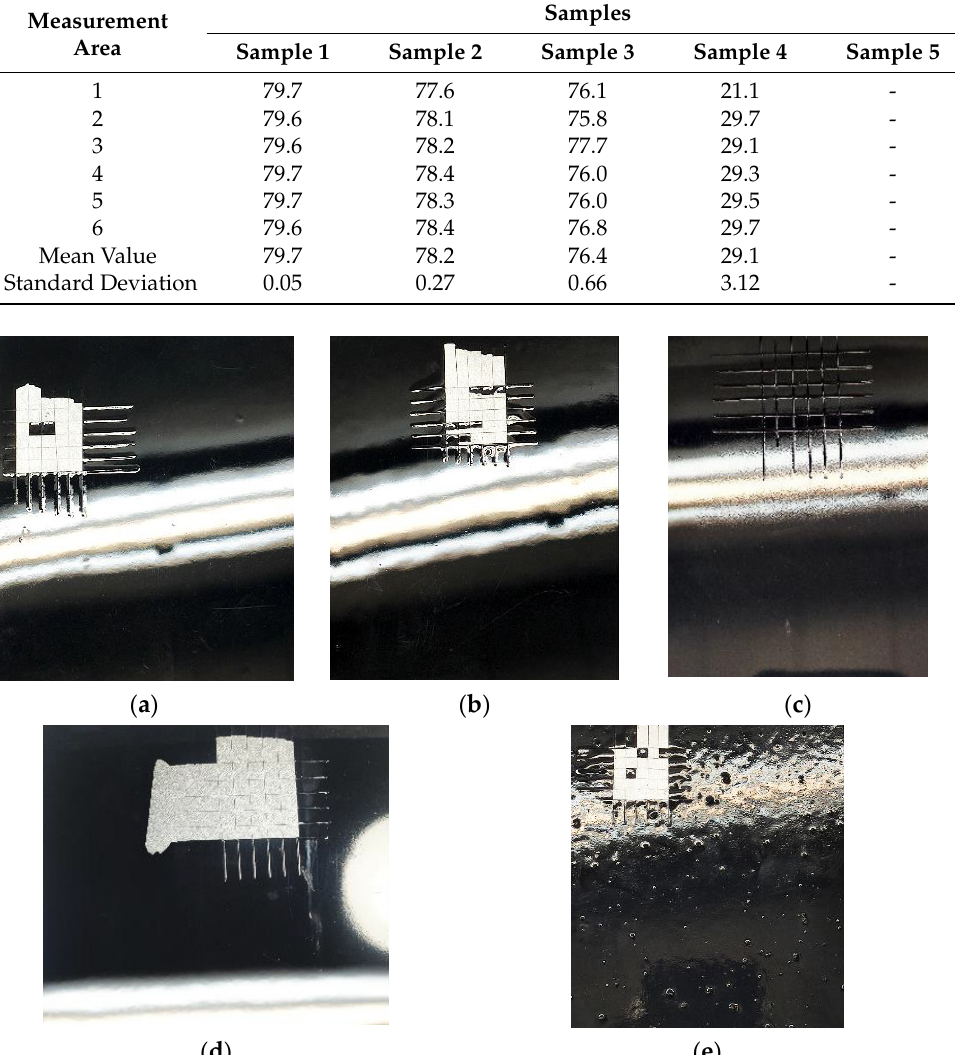
Table 6. The results of the measurements of the coating average gloss.